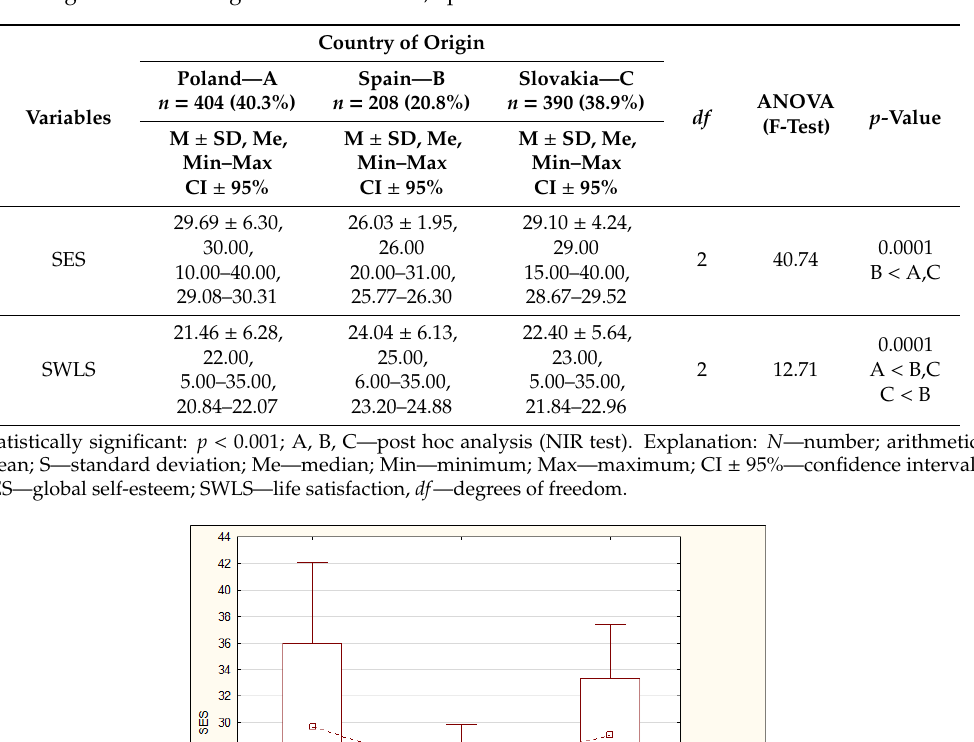
Table 2. Diversity of the results concerning global self-esteem according to SES and life satisfaction according to SWLS among students in Polish, Spanish and Slovak research.